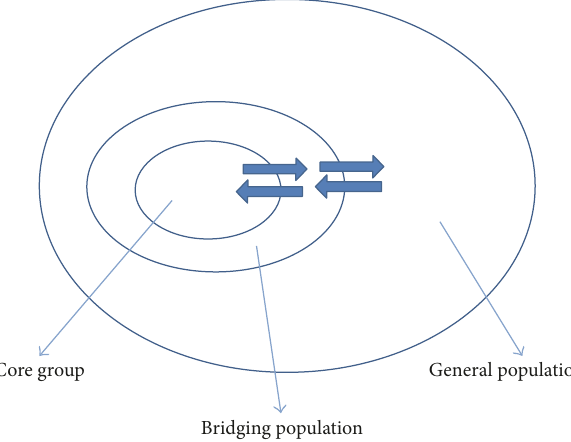
Figure 2: Sexual networks according to Anderson Transmission model